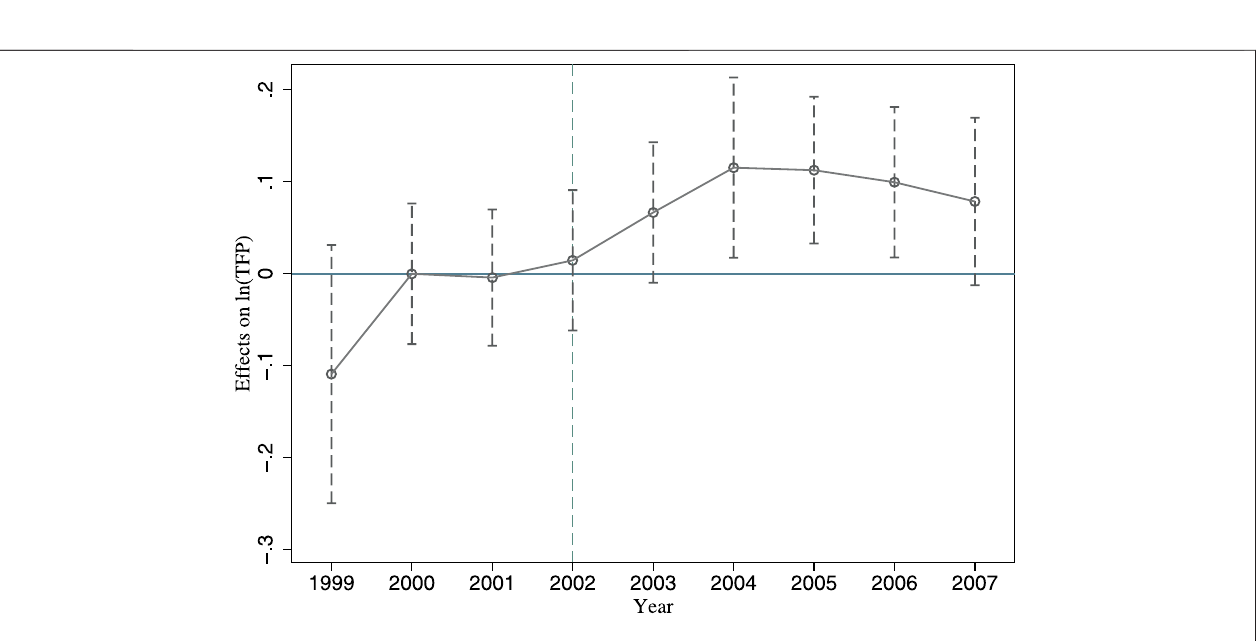
FIGURE 5 | Parallel trend test of TFP from 98 to